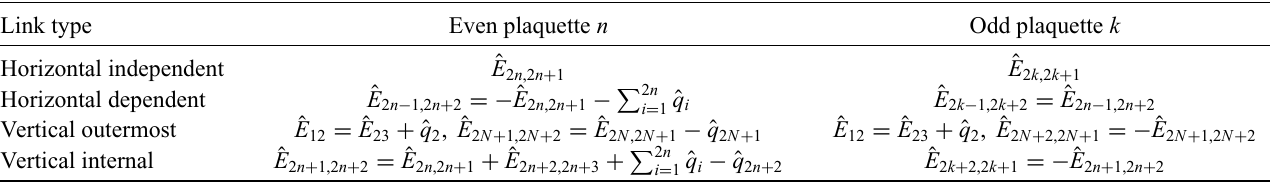
TABLE I. The electric field of each link in the ladder of Fig. 2(a). For the vertical outermost links, the cases of “even” and “odd” refer to the total number of plaquettes N